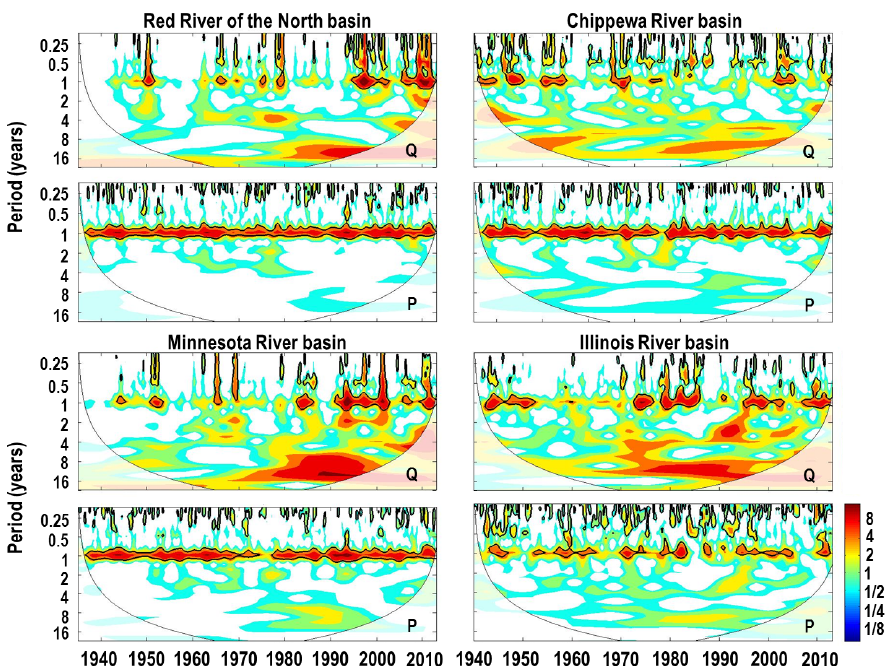
Figure 4. Continuous wavelet transform (CWT) energies for monthly volumetric streamflow ( Q ) and precipitation ( P ) time series.